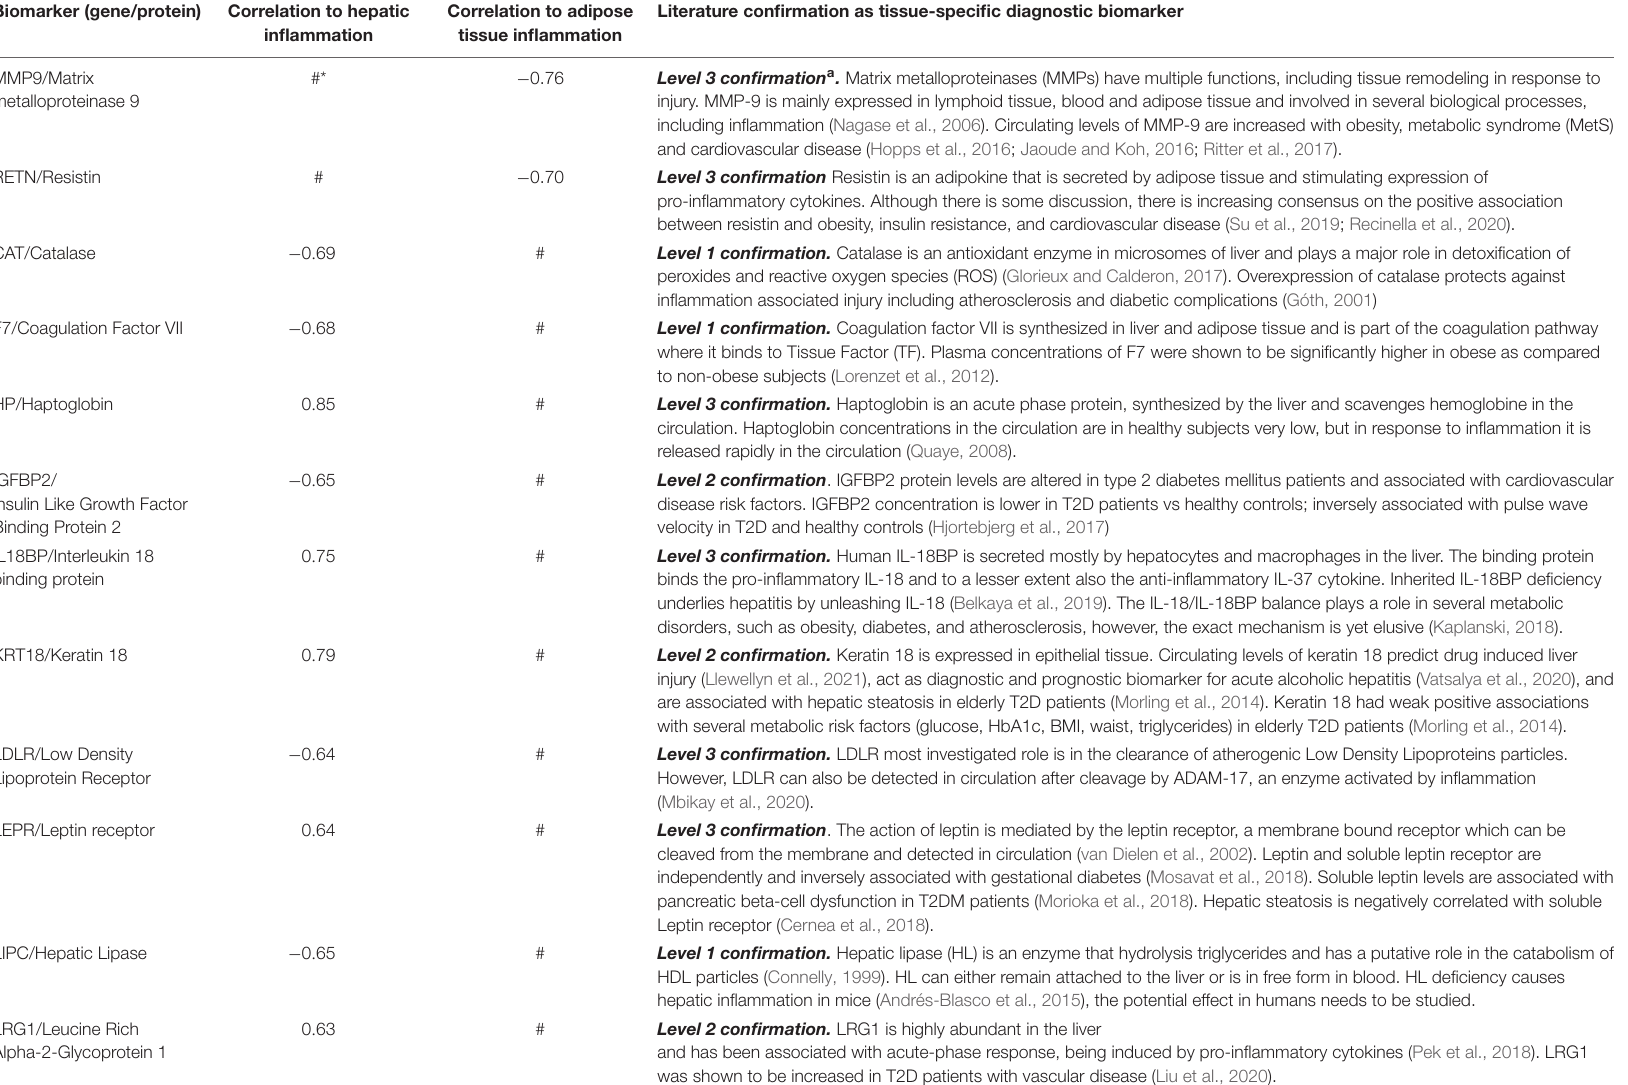
TABLE 3 | Spearman’s Rank correlation between the amount of inflammation in the tissue (liver and adipose tissue) and the expression of the candidate marker based on gene